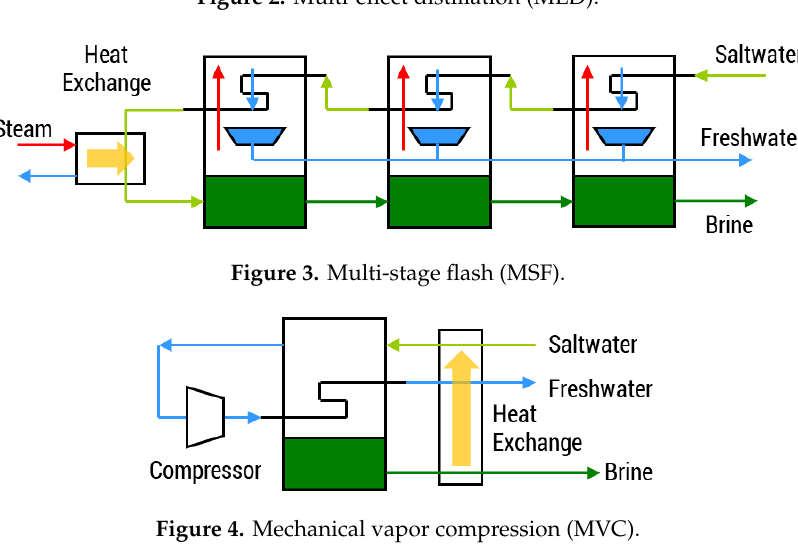
Figure 2. Multi-effect distillation (MED).